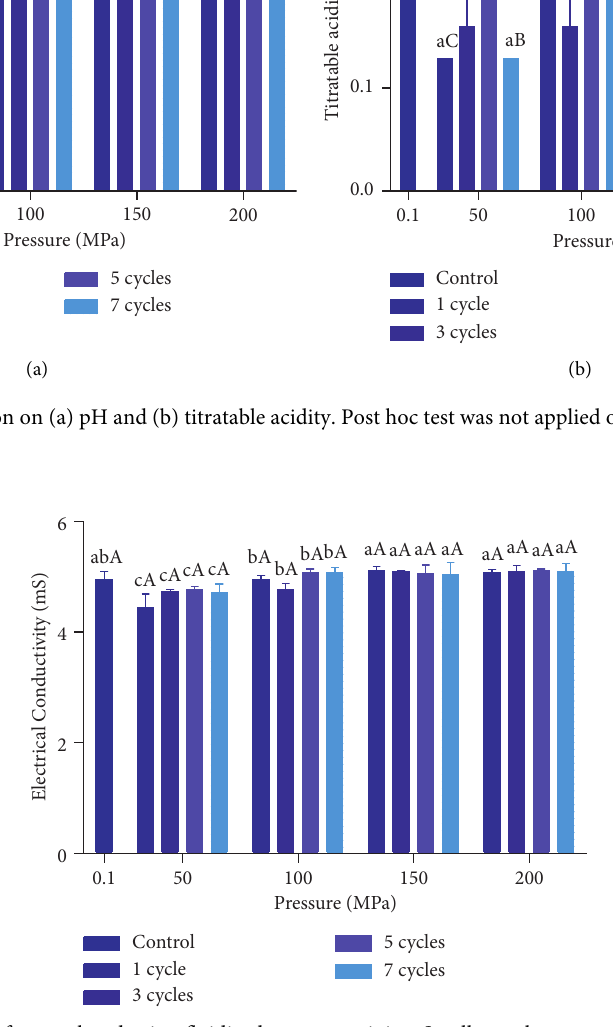
Figure 3: Electrical conductivity of control and microfluidized sugarcane juice. Small-case letters represent the effect of pressure, while capital-case letters represent the effect of passes. Datasets with different letters differ significantly at 5% level of significance by Duncan's multiple comparison